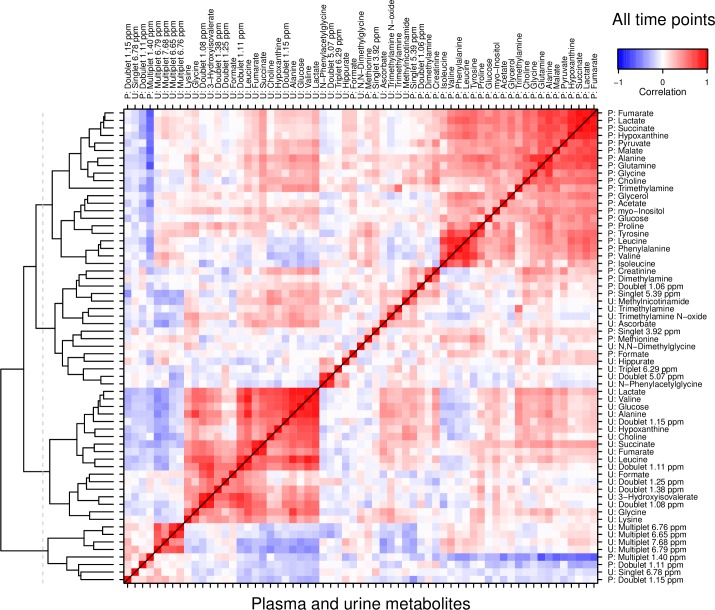
Correlations between plasma and creatinine-normalized urine metabolite concentrations at all time points combined.Left margin shows dendrogram from hierarchical cluster analysis (HCA) by which rows and columns are ordered. Two major, separate clusters emerge for plasma (top right) and urine metabolites (bottom left), suggesting a low overall coherence between the two, and justifying treating the two independently in further analysis.